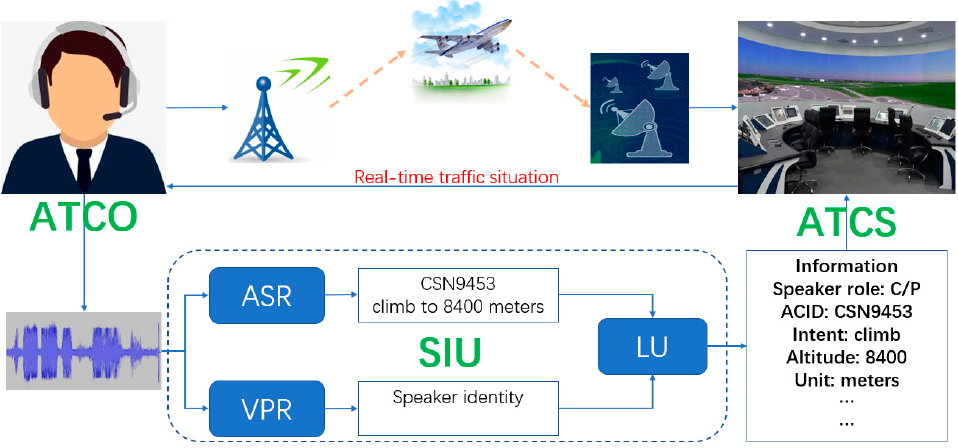
Figure 1. The air traffic control (ATC) procedure and spoken instruction understanding (SIU) roles in ATC.